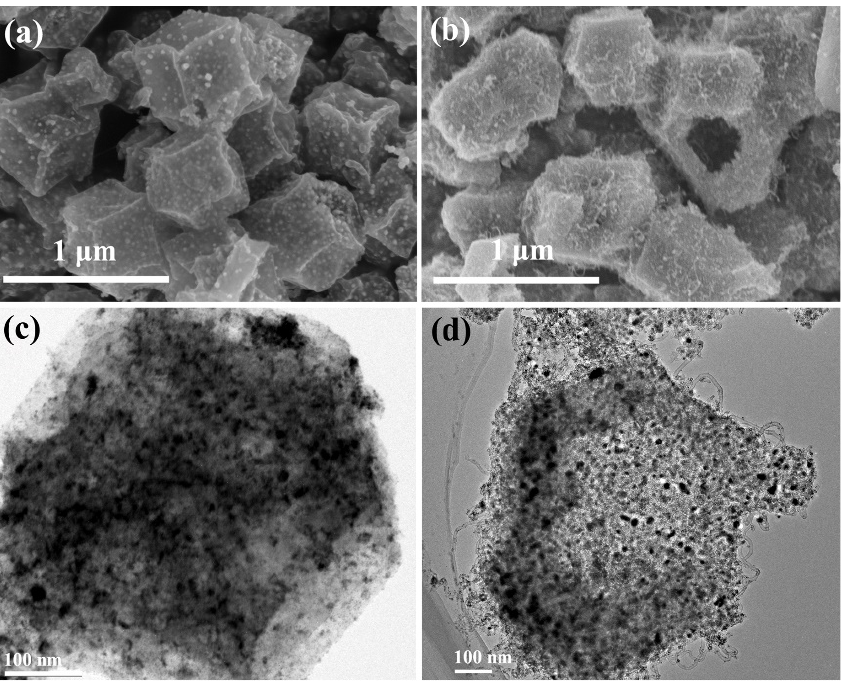
Figure 3. SEM images of ( a ) Pt/Co-PC800 and ( b ) Pt/Co-NCNT-HPC800; TEM images of ( c ) Pt/Co-PC800 and ( d ) Pt/Co-NCNT-HPC800.